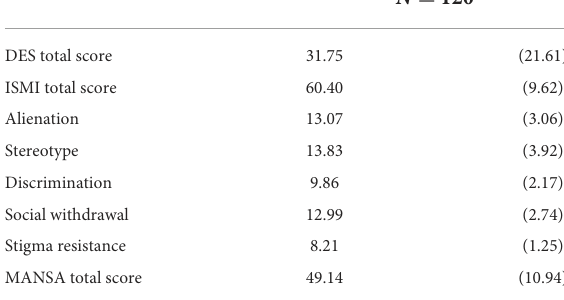
TABLE 3 Assessment